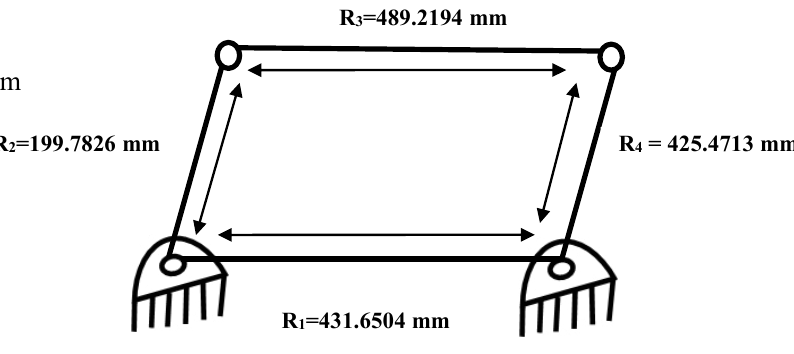
Figure 4: Four bar mechanism with link dimensions (mm)